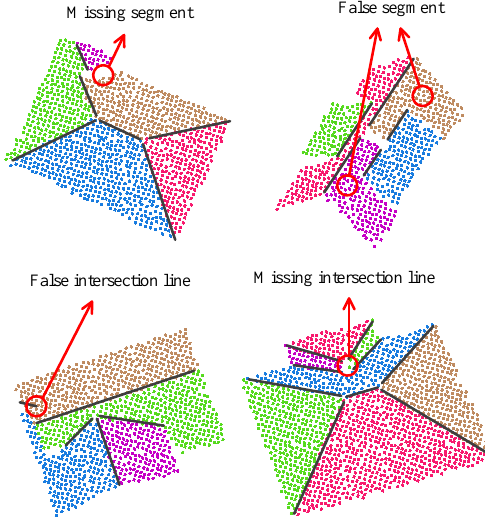
Figure 2. Four types of errors in the roof topology graphs. Figure 1. Building primitive library. Building primitives are grouped